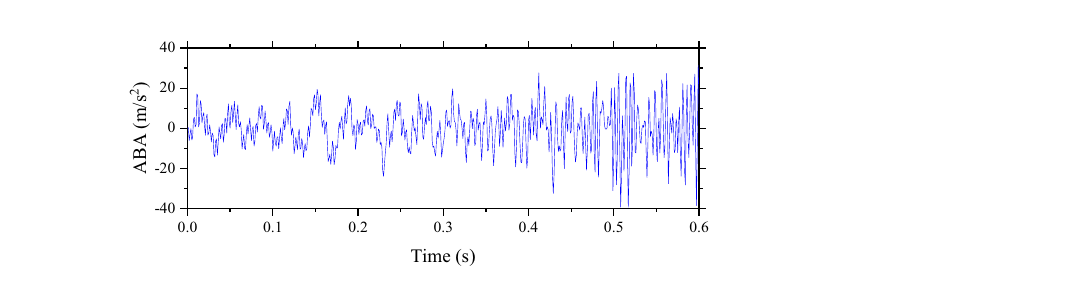
Figure 5. The ABA of the perfect condition when the speed is 200